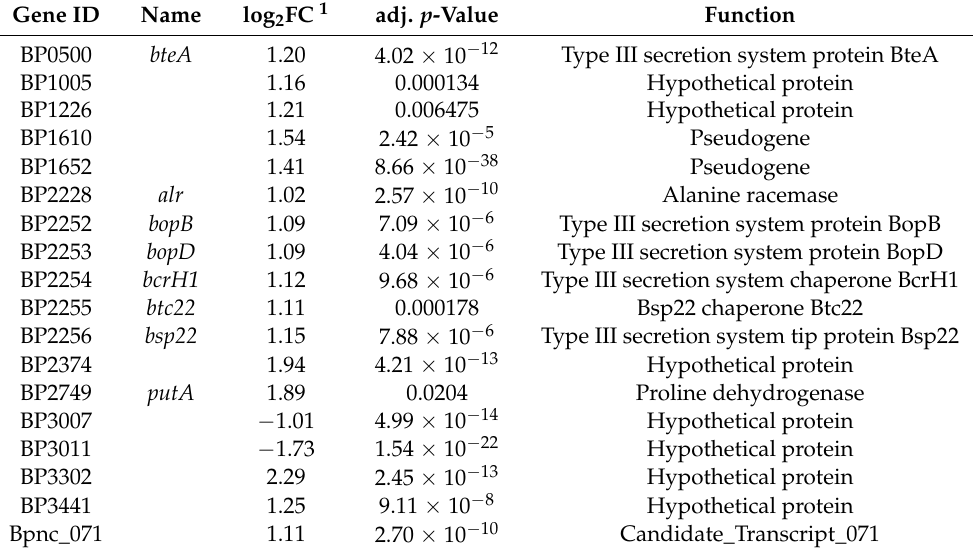
Table 1. List of genes significantly modulated in liquid cultures upon previous exposure to blood. Gene